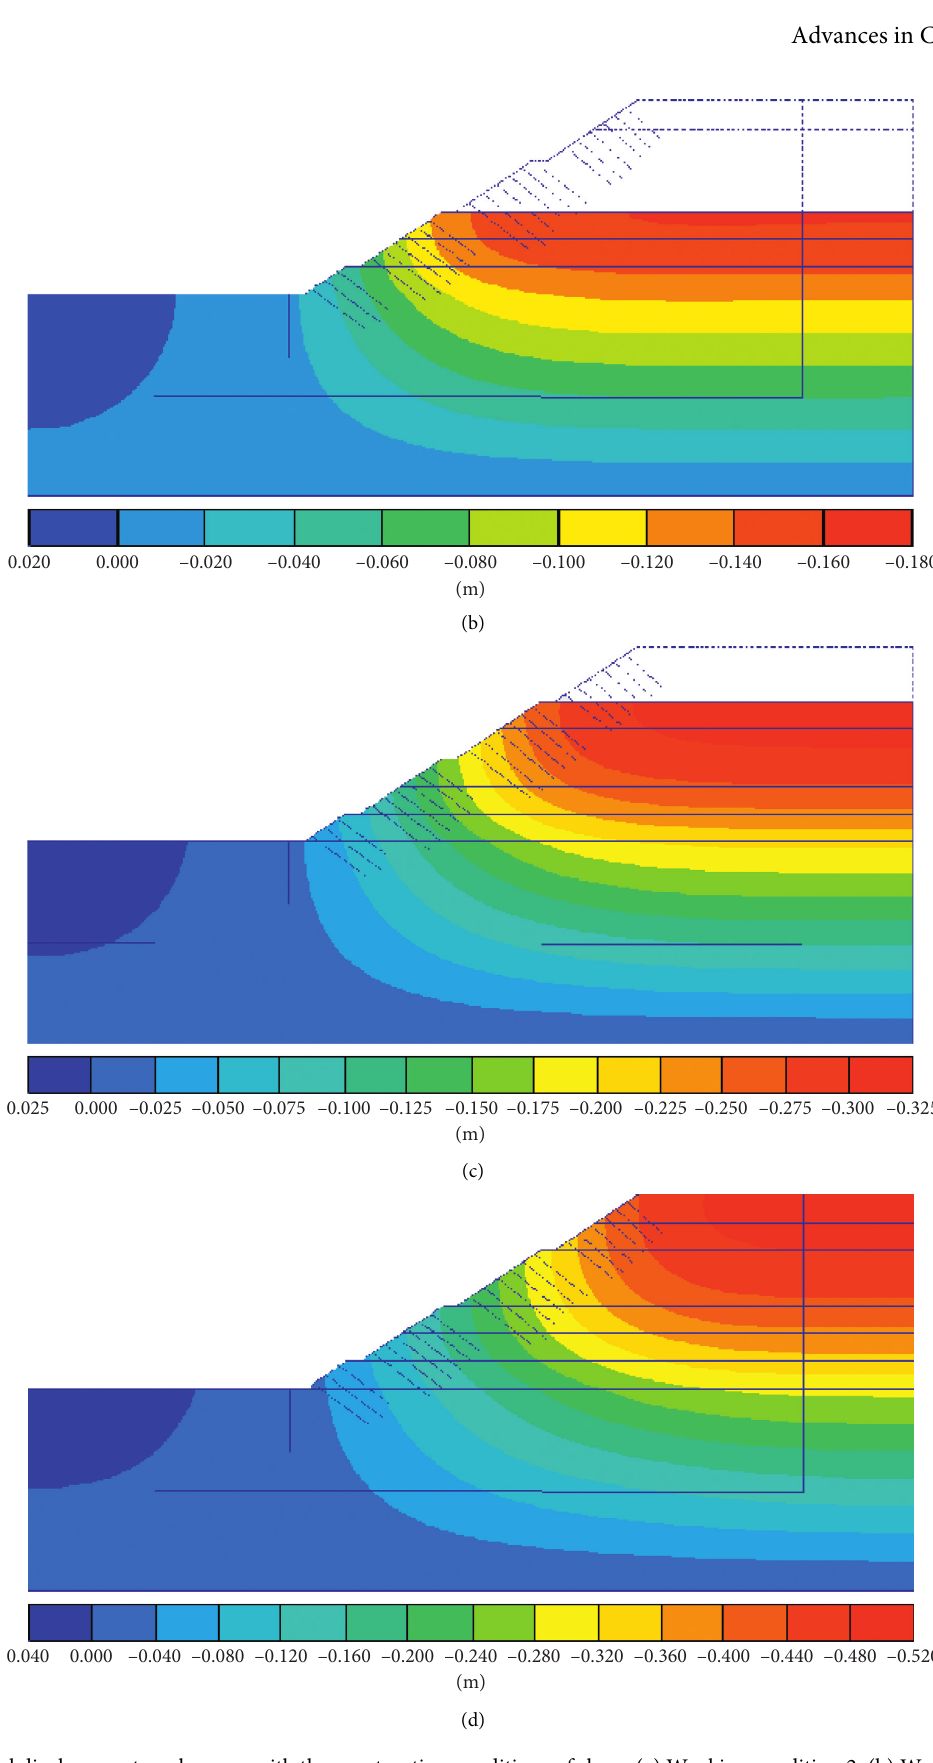
Figure 6: Vertical displacement nephogram with the construction conditions of slope. (a) Working condition 2. (b) Working condition 4. (c) Working condition 6. (d) Working condition